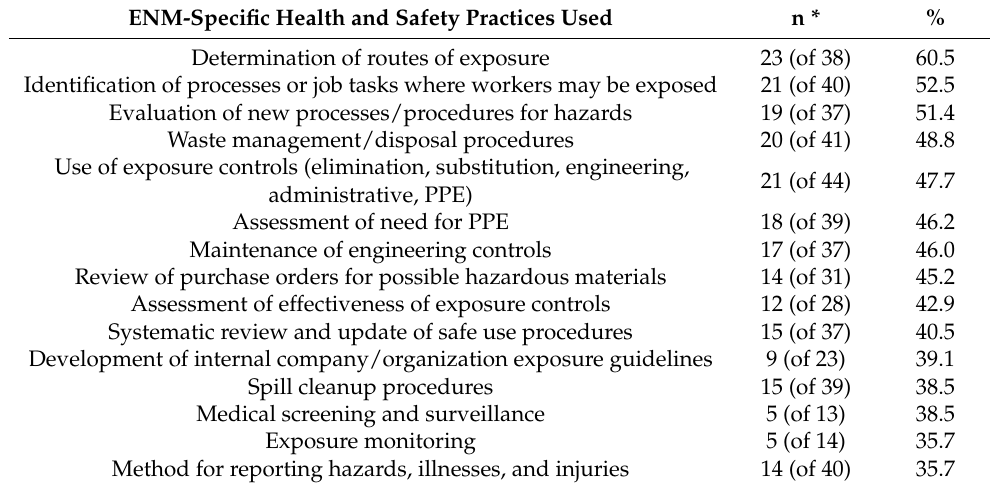
Table 1. ENM-Specific Safety Practices and Guidance Used. ENM-Specific Health and Safety Practices Used n * % Determination of routes of